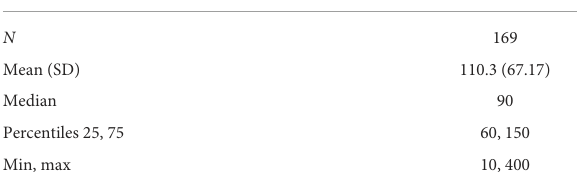
TABLE 10 Daily dose for the global population in Group 2 (first visit after 1 year of treatment).